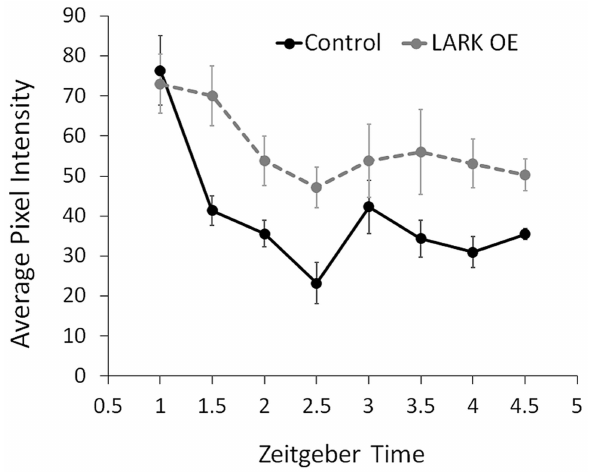
Figure 8. Increased LARK expression delays degradation of the PER protein. The average pixel intensity in confocal images of anti- PER immunoreactivity in large PDF neurons (l-LNvs) are quantified for control and LARK overexpression flies. Samples were taken every 0.5 hours starting at ZT1 till ZT4.5. For each data point, brain hemispheres from 4–6 different animals were analyzed. Error bar represent SEM. A two-way ANOVA of genotype and time find a significant difference between control and LARK OE (p=0.006289).